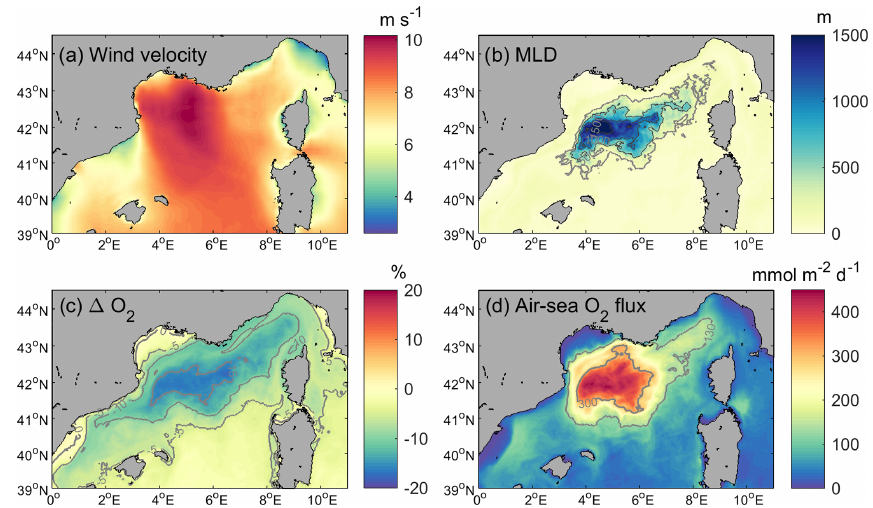
Figure 7. Modelled (a) wind velocity (ms − 1 ), (b) mixed-layer depth (m) (dark grey lines represent 500, 1000 and 1500 isocontours and light grey line the contour of the deep-convection area), (c) oxygen saturation anomaly (%) at the surface and (d) air-to-sea oxygen flux (mmolm − 2 d − 1 ), averaged over the 2013 deep-convection period (15 January–8 March; 15–24 March).